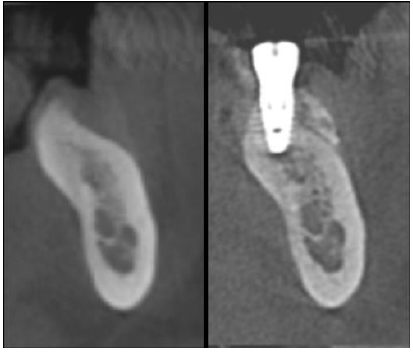
Figure 8. Cone beam computed tomography (CBCT) scans of a mandibular site before surgery (left side) and after removal of the titanium mesh (right side), 8 months after the reconstructive procedure.